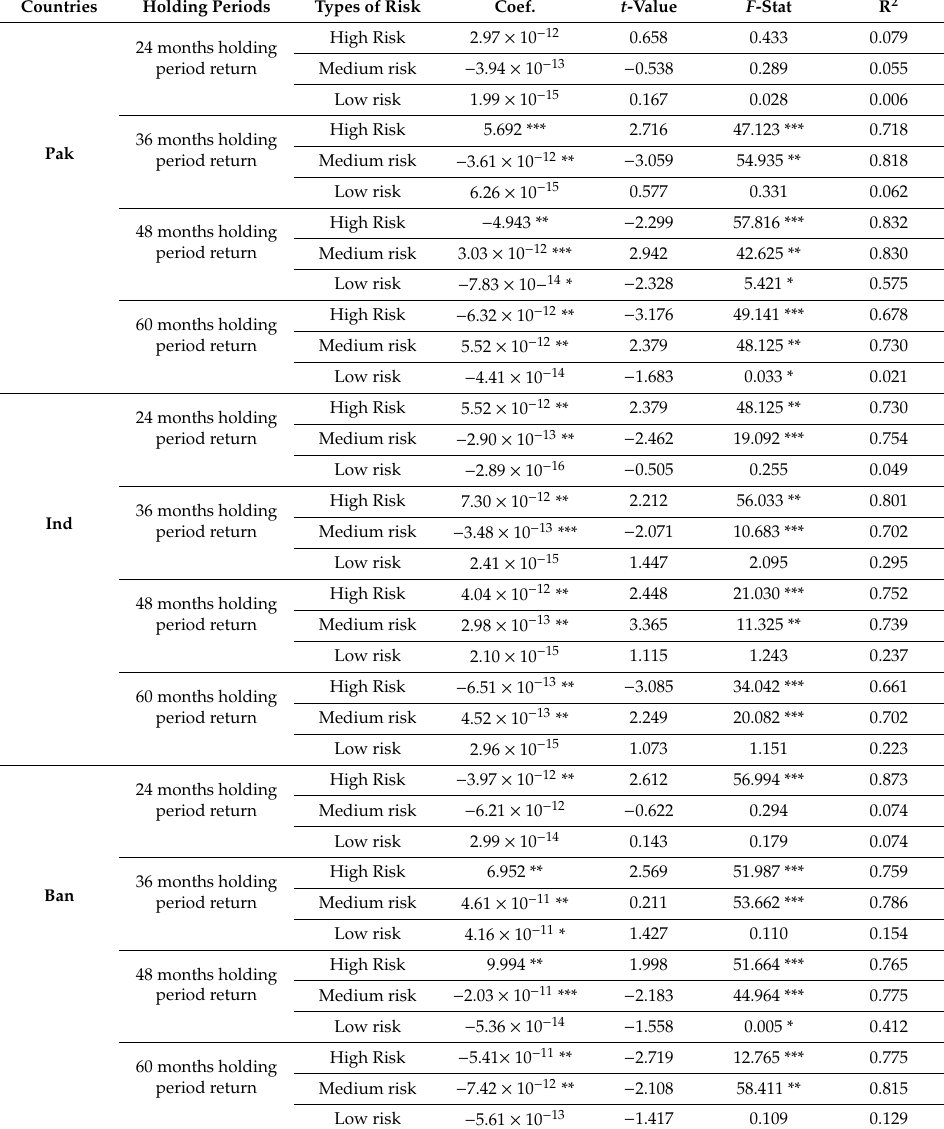
Table 6. Hypotheses testing W R T contrarian